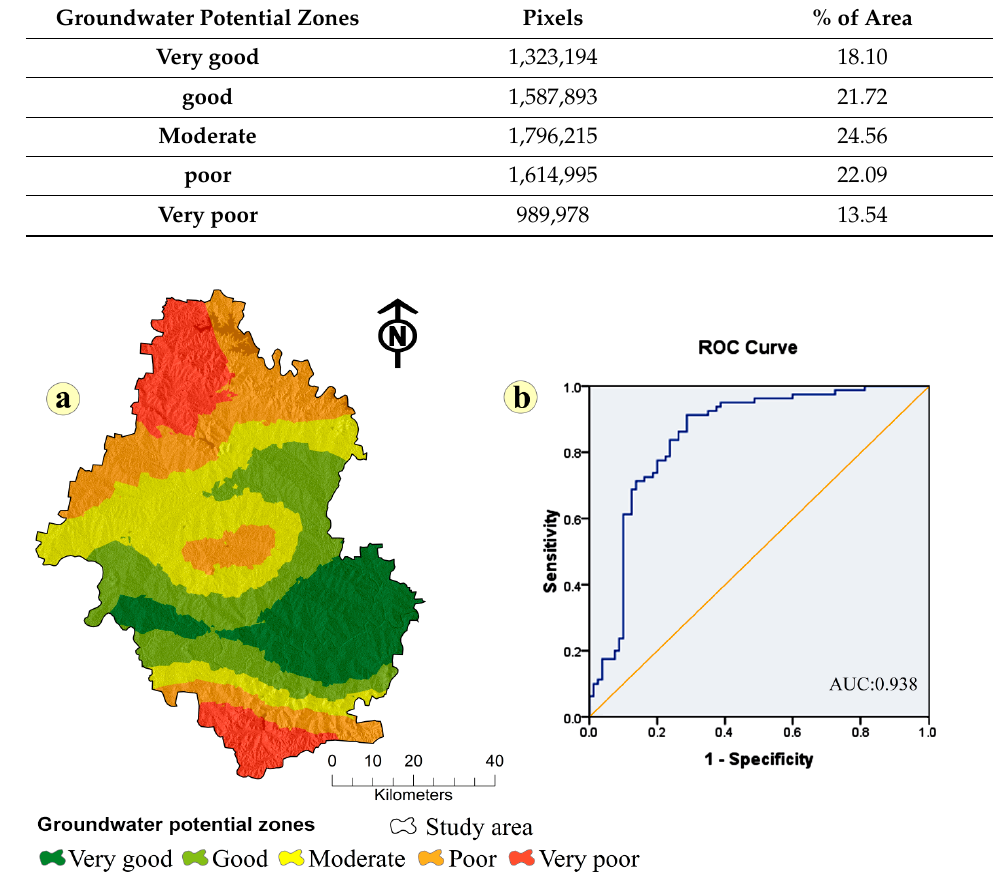
Figure 7. ( a ) groundwater potential zones using ensemble model, ( b ) ROC curve of ensemble model. Validation of Groundwater Potential Maps Using ROC Curve and Field Data The ROC curve is a threshold-based method for evaluating classified outcome